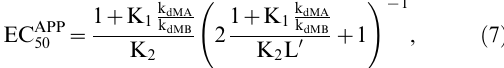
PLoS Computational Biology |